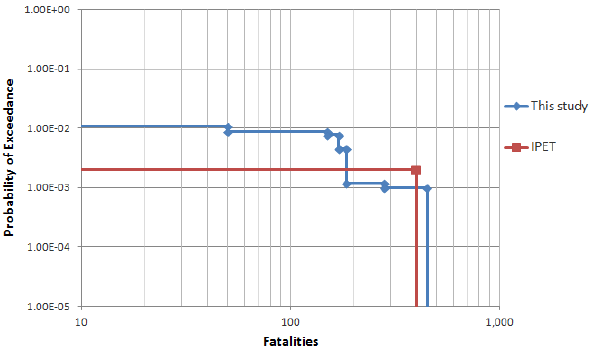
Figure 8. Results of this study (risk estimate for the metro bowl) and results of IPET (2009b) for post-Katrina situation and with 0% pumping assumed for the 1 / 500 per year estimate and 100% pump- ing assumed for the 1 / 50 and 1 / 100 per year